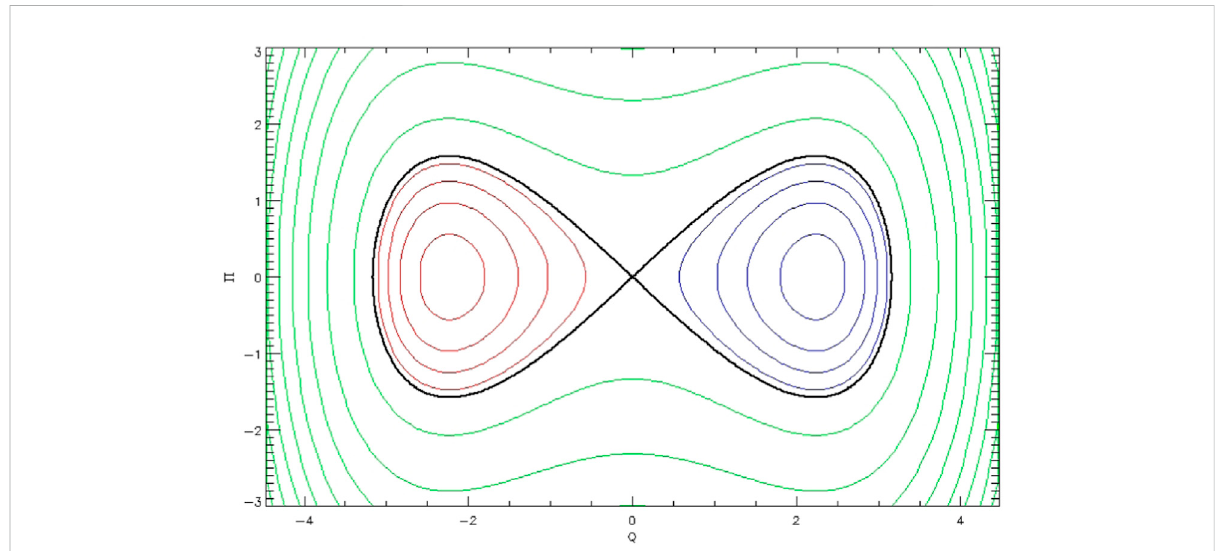
FIGURE 5 Contours of a two-lobe Hamiltonian of the form of Eq. 19. The contour colors correspond to those of Figure